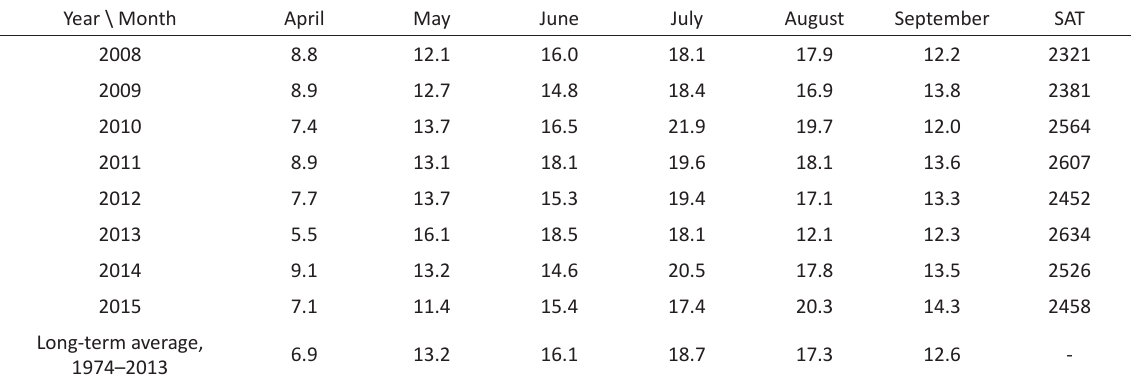
Table 2. Average temperature and the sum of the active temperatures (SAT) during the maize growing season (April-September) in 2008–2015, Kaunas Meteorological Station